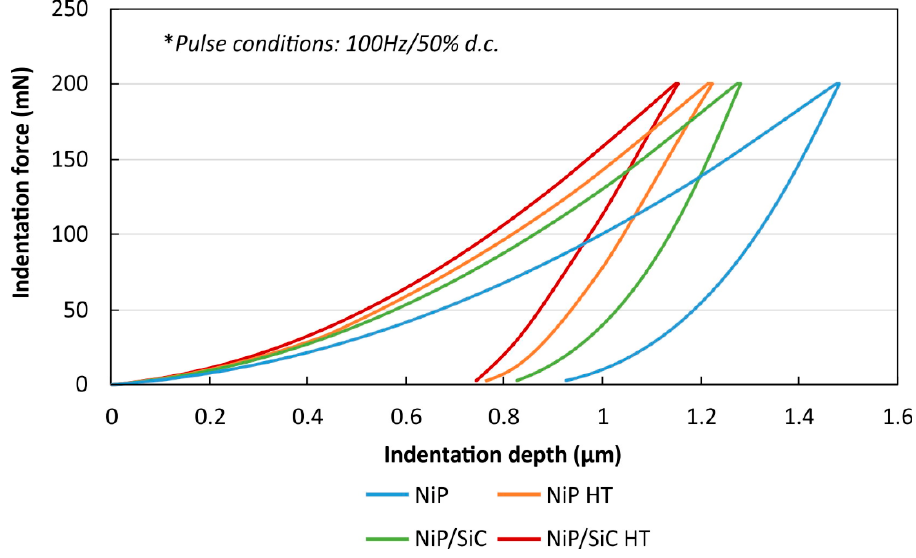
Figure 7. Nanoindentation load–depth curves of as-plated Ni-P, Ni-P/SiC nanocomposites, and the heat treated coatings.